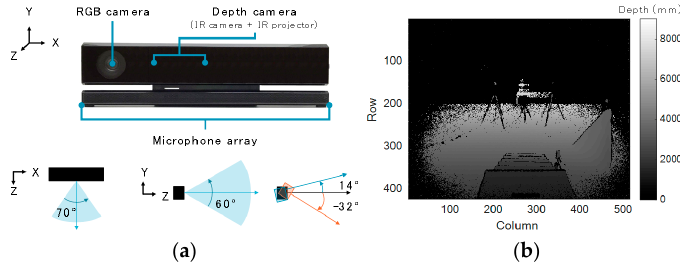
Figure 3. ( a ) Kinect v2 and its camera positions; ( b ) depth data acquired by Kinect v2.